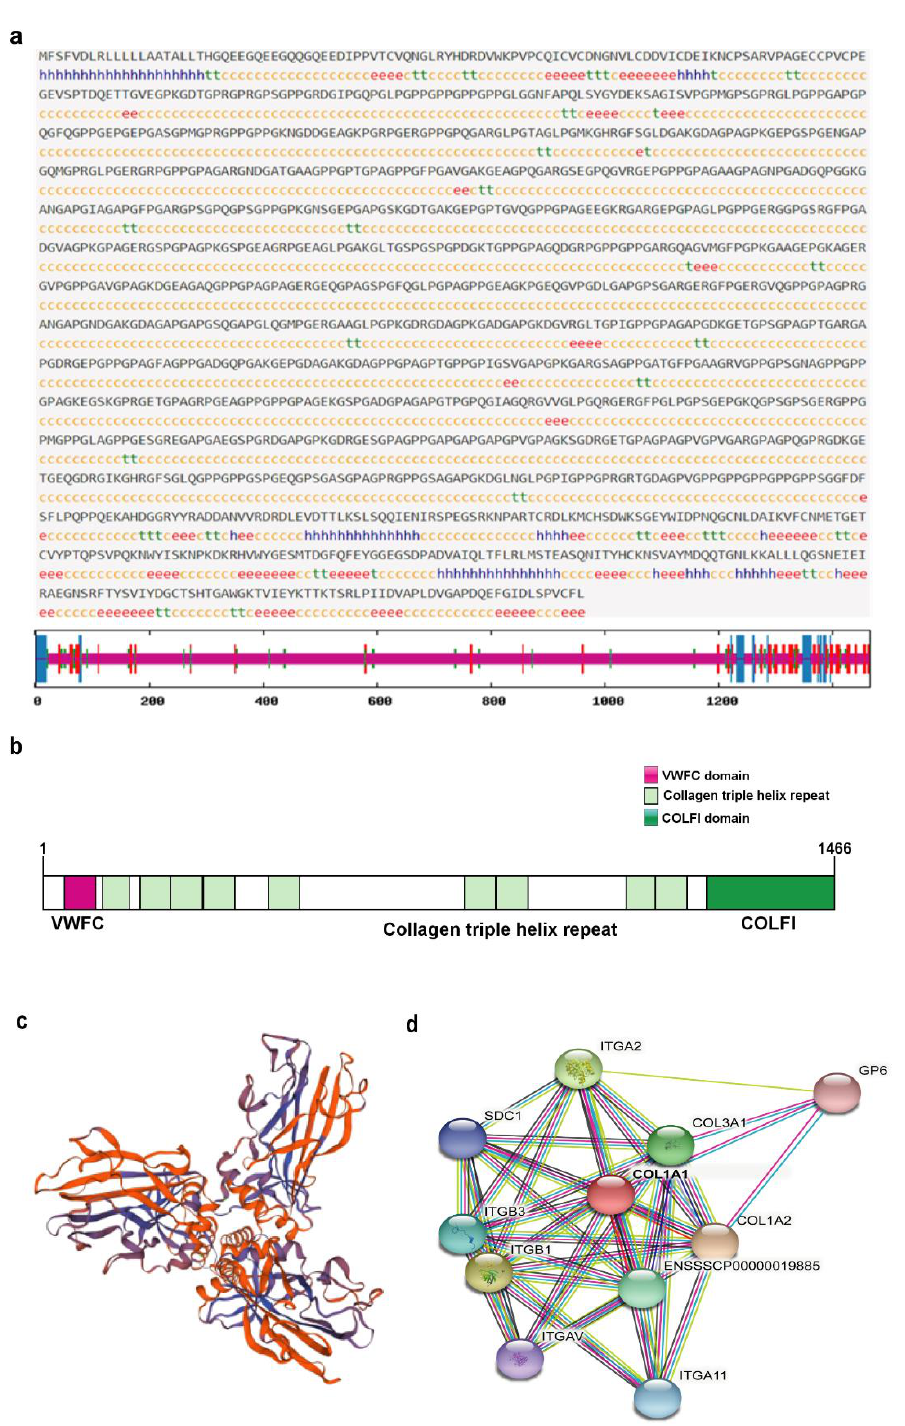
Figure 6. Structural and functional analyses of porcine COL1A1. ( a ) Predicted secondary structure (H and blue line, α helix; t and green line, β turn; e and red line, Extended chain; c and purple line, Random coil); ( b ) Domain prediction; ( c ) Tertiary structure prediction; ( d ) Protein interaction analysis.